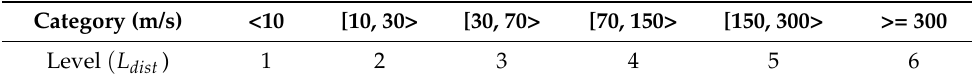
Table 9. Fire event distance categories.